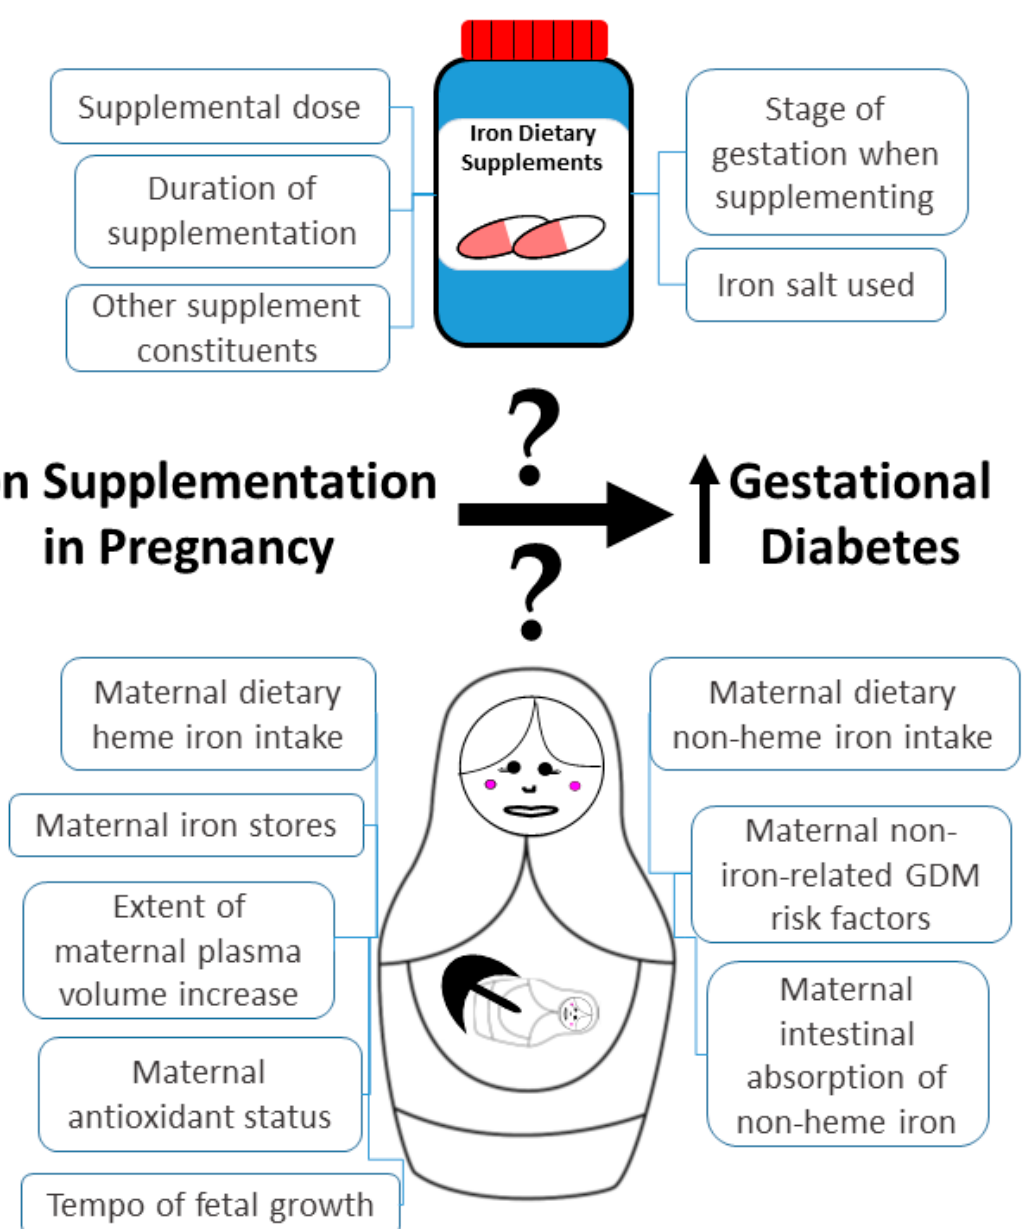
Figure 1. Some of the possible causes of heterogeneity in studies attempting to test whether iron supplementation in pregnancy is associated with an increased risk of developing GDM.